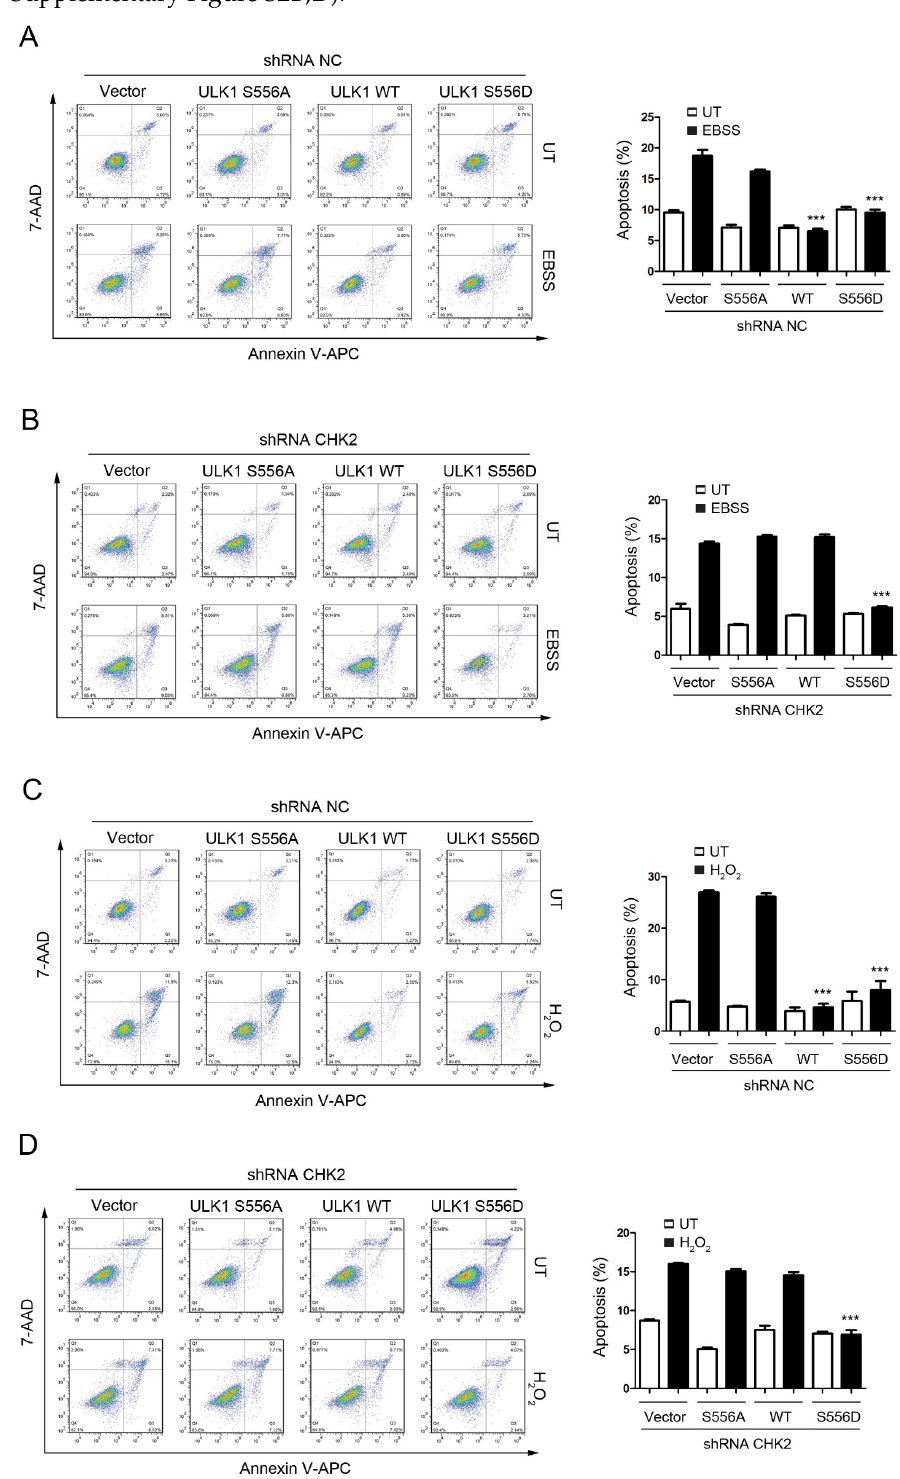
Figure 4. CHK2-ULK1 mediated autophagy protects cells against metabolic stress-induced cell death. ( A , B ) Flow cytometry analysis of apoptosis was performed in H1299 cells expressing the indicated plasmids treated with EBSS for 8 h with ( A ) or without ( B ) CHK2. The results from three independent experiments are presented as mean ± SEM. *** p < 0.001 compared to ULK1 S556A treated with EBSS. ( C , D ) Flow cytometry analysis of apoptosis was performed in H1299 cells ex- pressing the indicated plasmids treated with H 2 O 2 (500 μM) for 8 h with ( C ) or without ( D ) CHK2. The results from three independent experiments are presented as mean ± SEM. *** p < 0.001 com- pared to ULK1 S556A treated with H 2 O 2 (500 μM) stimulation.